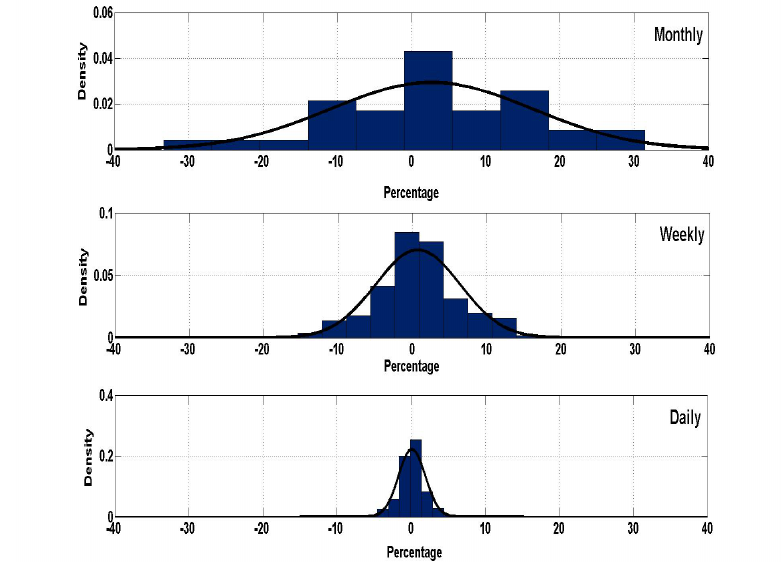
Figure 11. The distribution of the default risk of a collateralized European put option for three different recollateralization periods with parameters: S r = 0 . 05 , r = 0 . 06 , r = 0 . 01 , T = 3 and σ = 0 . 3 R F D